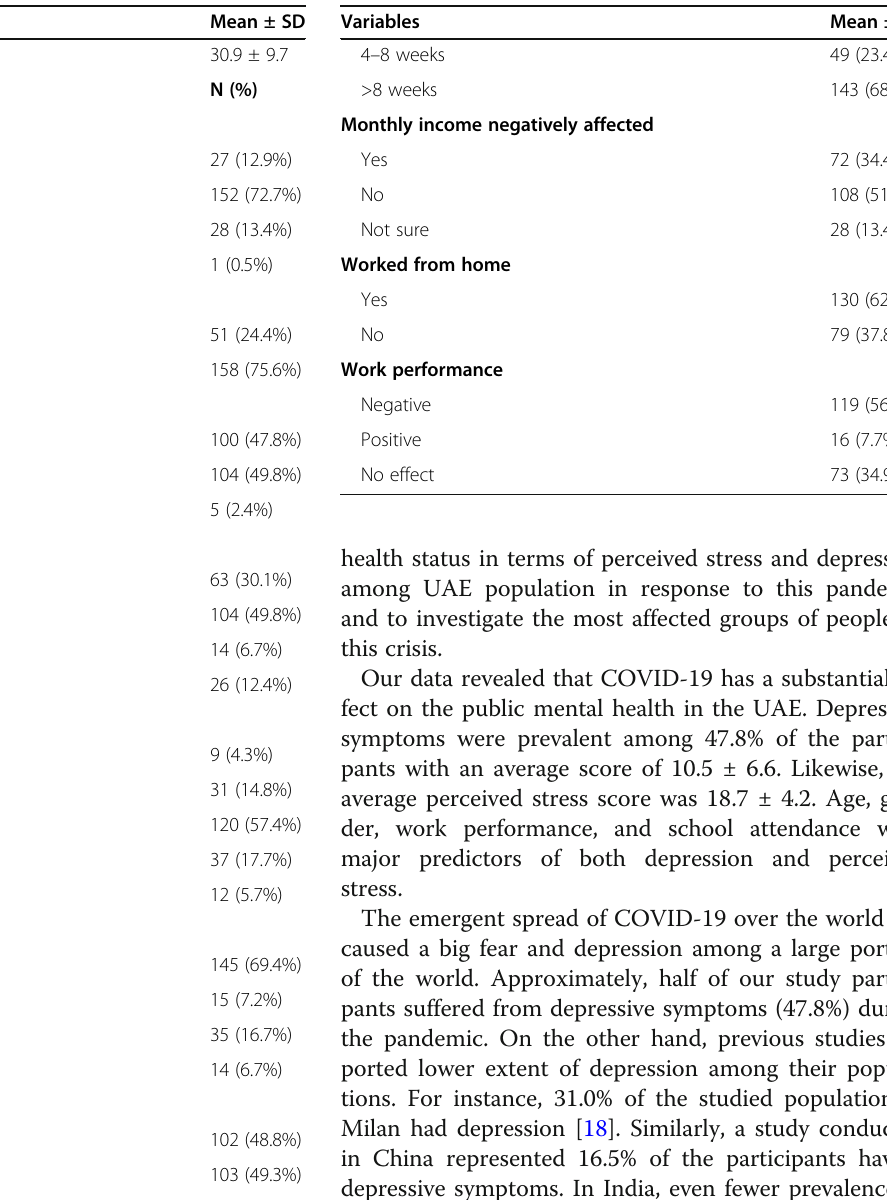
Table 1 Baseline characteristics of the participants